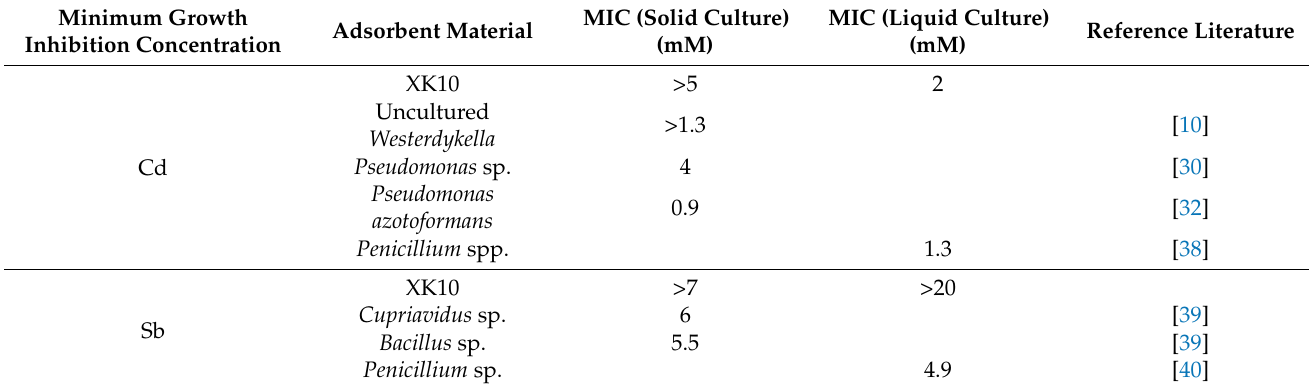
Table 2. The minimum inhibitory concentrations of Cd and Sb by different